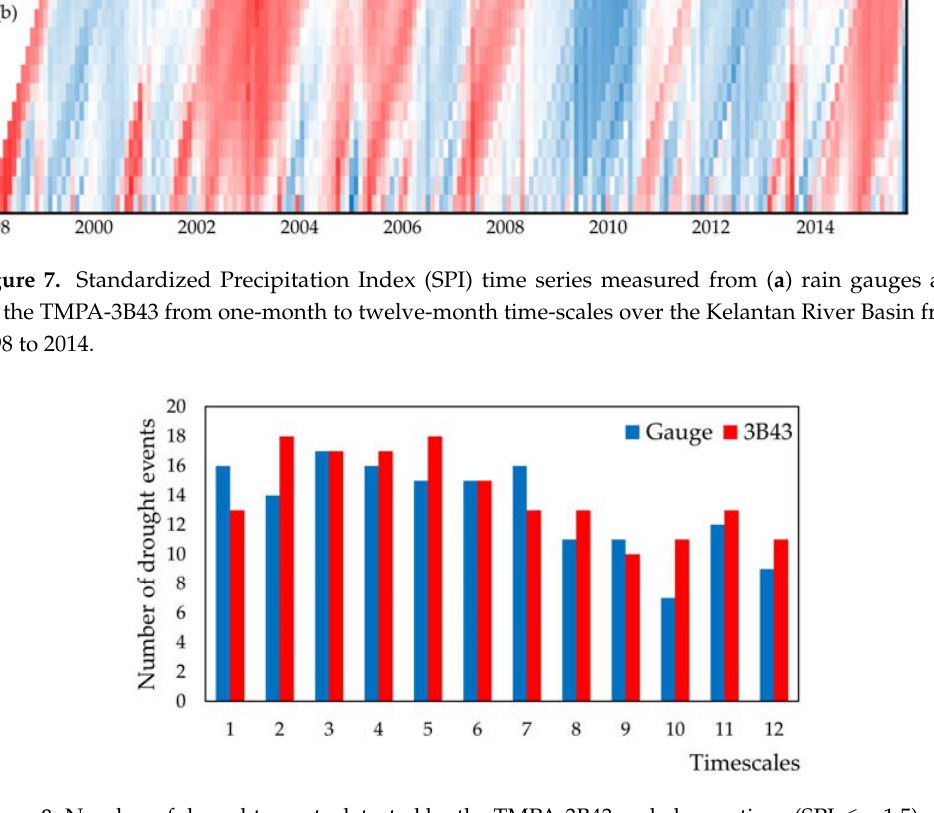
Figure 8. Number of drought events detected by the TMPA ‐ 3B43 and observations (SPI ≤ − 1.5) over the Kelantan River basin for the period of 1998–2014.